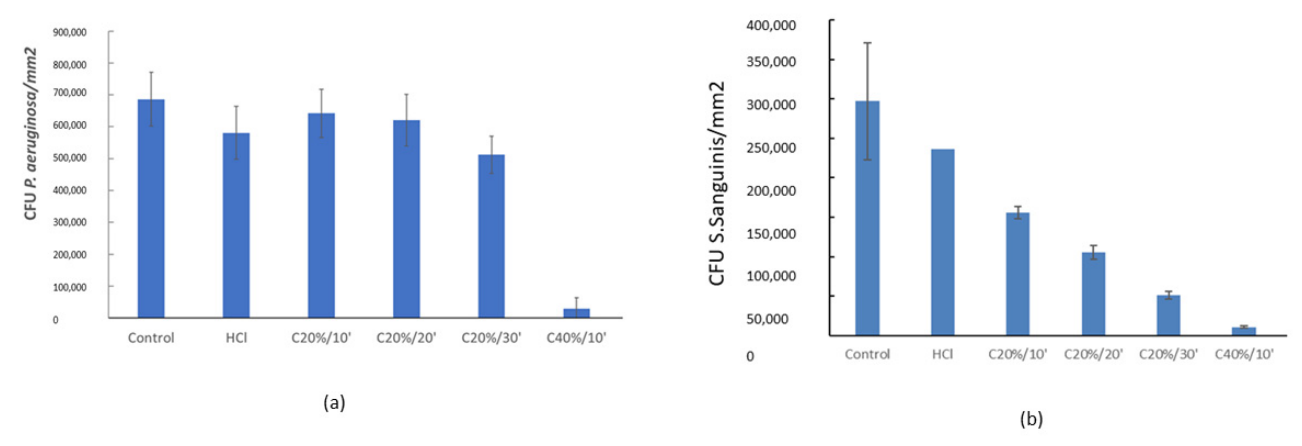
Figure 6. Analysis of P. aeruginosa ( a ) and S. sanguinis ( b ) adhesion for the different treatments.